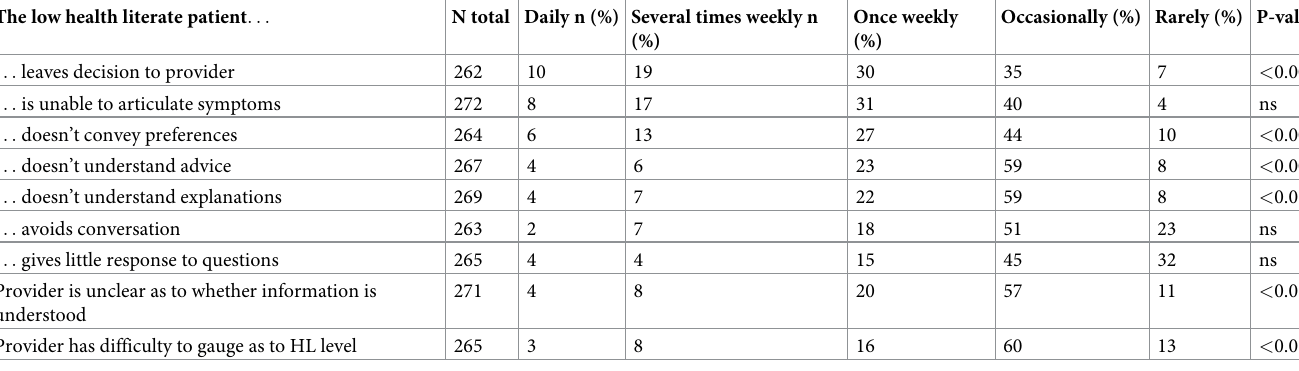
Table 4. Challenges with low health literate patients during a consultation � . The low health literate patient